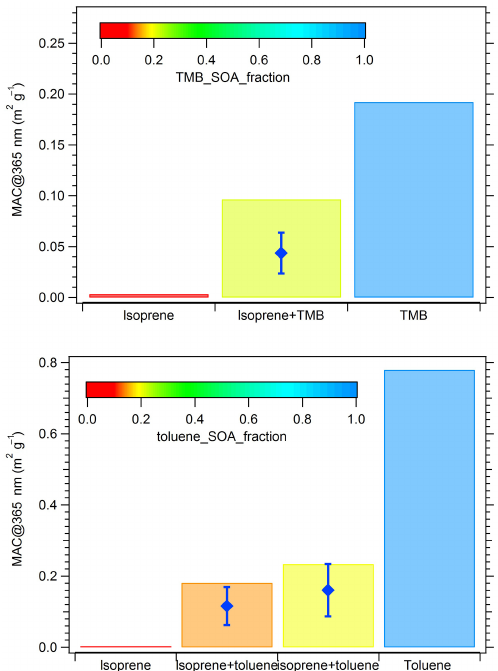
Figure 4. Comparison of MAC values from single-precursor and mixed-precursor experiments. Bars represent the MAC values at 365nm from measurements, and are color-coded by the mass frac- tion of aromatic SOA. The blue diamonds represent the predicted MAC values based on the modeled fraction of isoprene SOA and aromatic SOA, with error bars indicating the